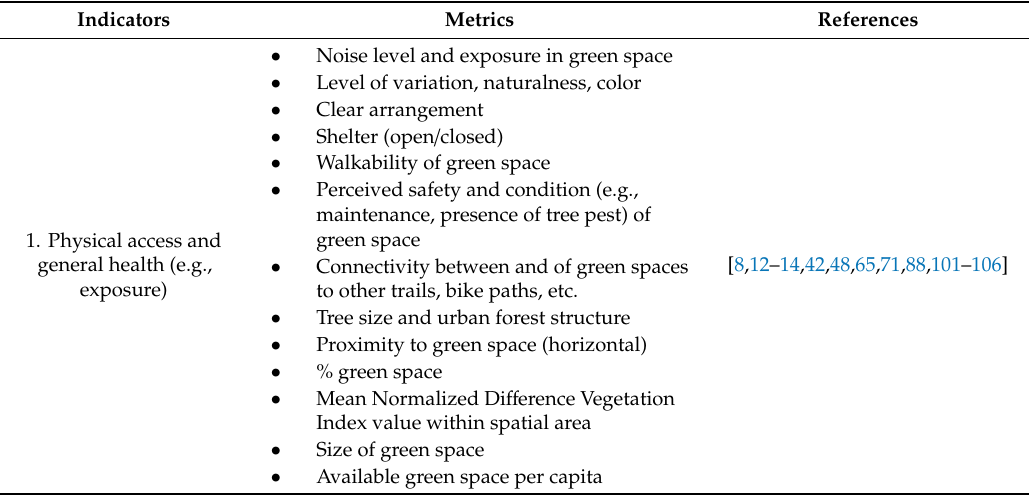
Table A1. Health